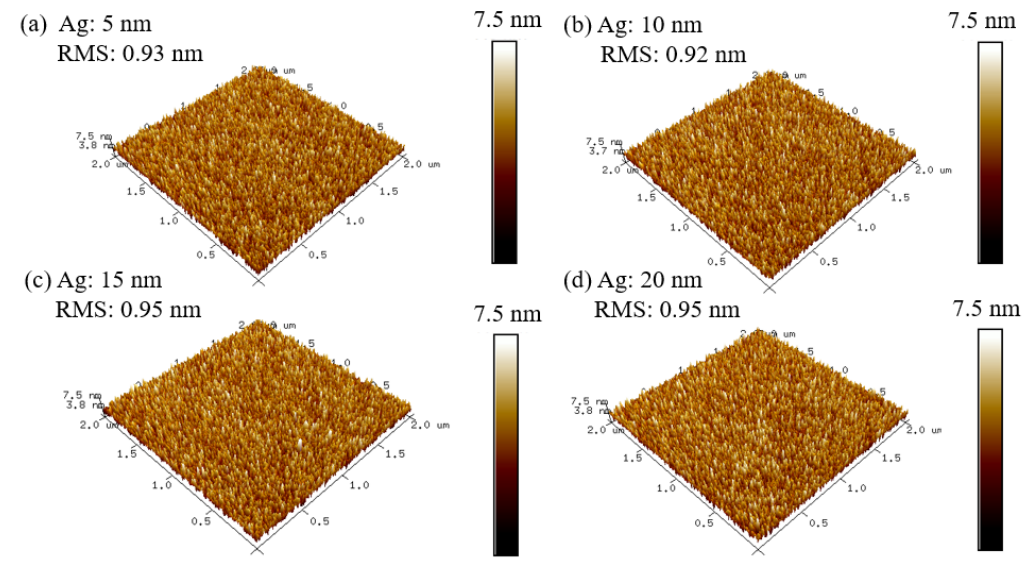
Figure 3. AFM images of ITO/Ag/ITO samples with different Ag interlayer thicknesses: ( a ) 5 nm, ( b ) 10 nm, ( c ) 15 nm and ( d ) 20 nm.